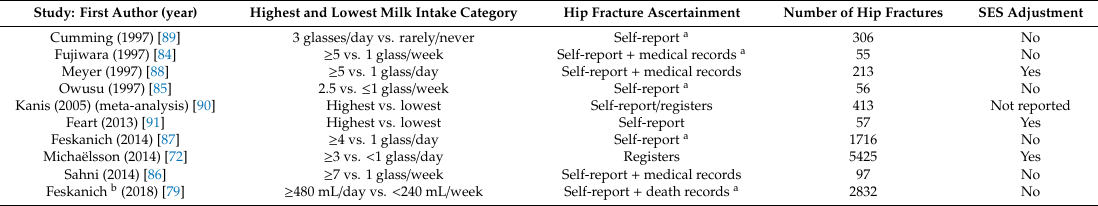
Table 1. Cohort studies of milk consumption in relation to hip fractures: milk intake categories, hip fracture ascertainment method, number of hip fractures, and socioeconomic status (SES) adjustment. Study: